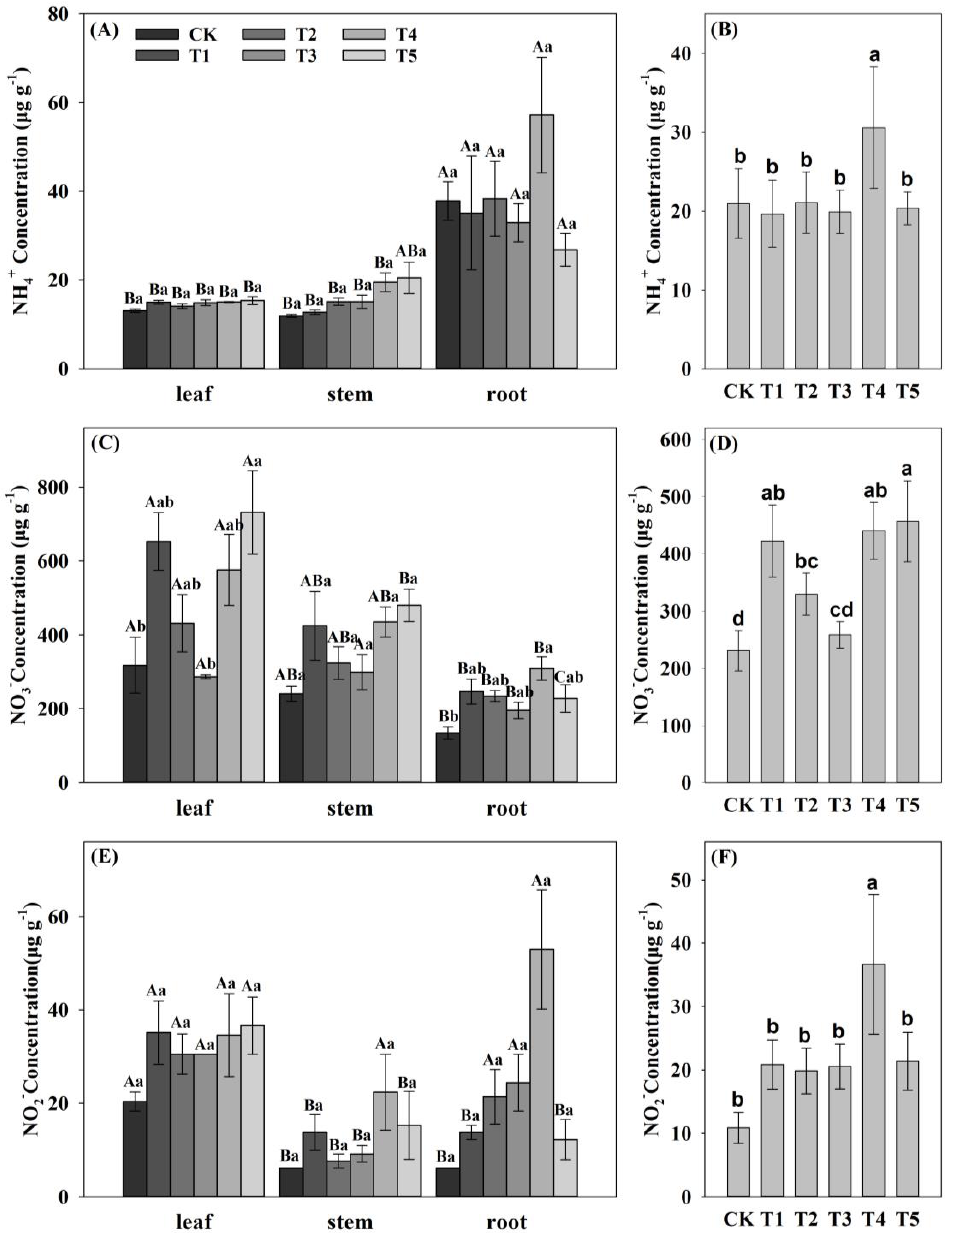
Figure 7. Differences of NH 4+ , NO 3 − , and NO 2 − concentrations of pecan under varying NH 4+ :NO 3 − ratios. Differences of NH 4+ concentrations in pecan leaves, stems, and roots under varying NH 4+ :NO 3 − ratios ( A ). The mean values of NH 4+ concentrations in pecan leaves, stems, and roots under varying NH 4+ :NO 3 − ratios ( B ). Differences of NO 3 − concentrations in pecan leaves, stems, and roots under varying NH 4+ :NO 3 − ratios ( C ). The mean values of NO 3 − concentrations in pecan leaves, stems, and roots under varying NH 4+ :NO 3 − ratios ( D ). Differences of NO 2 − concentrations in pecan leaves, stems, and roots under varying NH 4+ :NO 3 − ratios ( E ). The mean values of NO 2 − concentrations in pecan leaves, stems, and roots under varying NH 4+ :NO 3 − ratios ( F ). Upper capi- tal letters indicate significant differences between organs ( p < 0.05), and lowercase letters indicate significant differences between varying NH 4 + :NO 3 − ratios ( p <